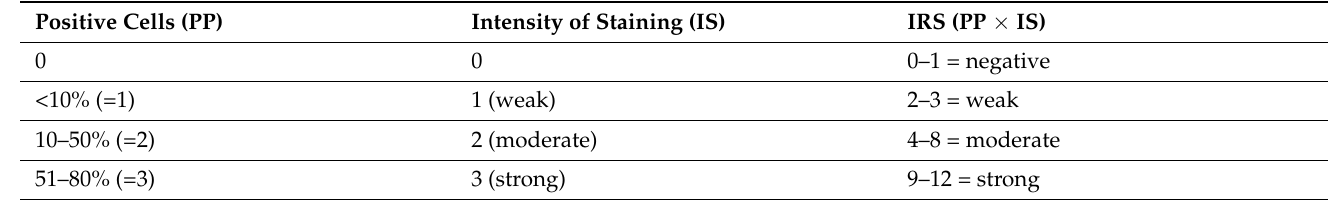
Table 5. Assessment of expression score in